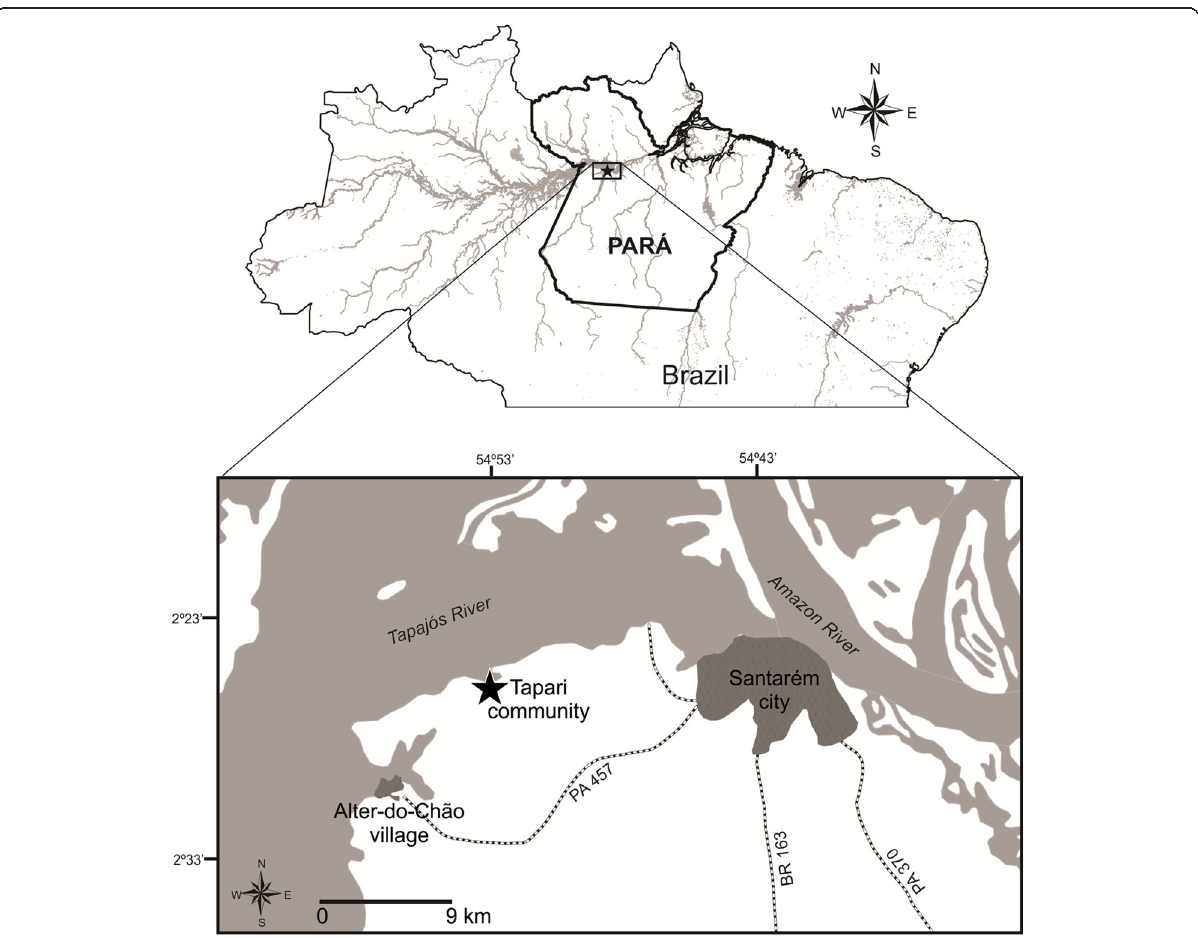
Figure 3 Map of the Pará state, in the northern Brazil. Inset emphasizes the hydrographic basin of the Tapajós river. The black star indicates Tapari, where the envenomation provoked by R. amazonicus occurred. Distance is shown on a relative scale bar. The map was created using the free software QGis